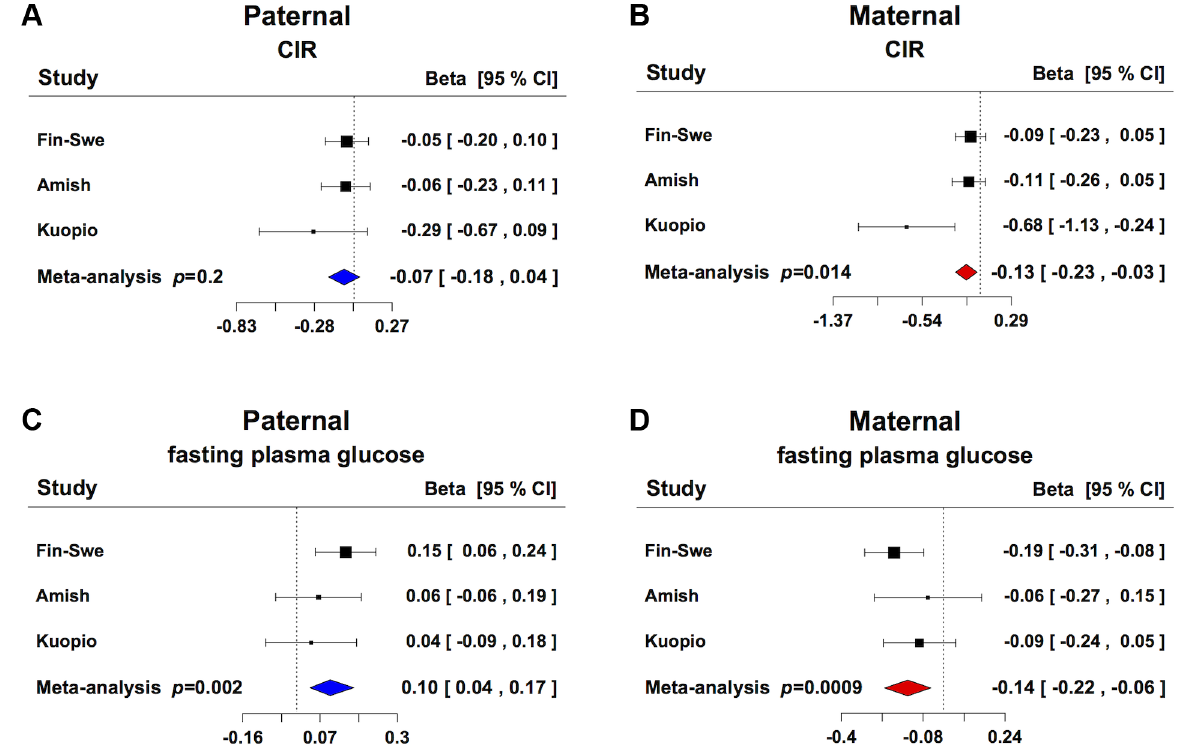
Figure 2. Parent-of-origin effect of GRB10 rs933360 on insulin secretion and glucose levels. (A) No significant effect for CIR was observed from the paternally transmitted A-allele. (B) Carriers of the maternally transmitted A-allele showed lower CIR compared to the G-allele. (C) Carriers of the paternally transmitted A-allele had elevated fasting plasma glucose levels, whereas (D) the maternally transmitted A-allele was associated with lower fasting plasma glucose levels. Fin-Swe=Trios from Finland and Sweden, Amish=Amish Family Diabetes Study, Kuopio=Kuopio Offspring Study.